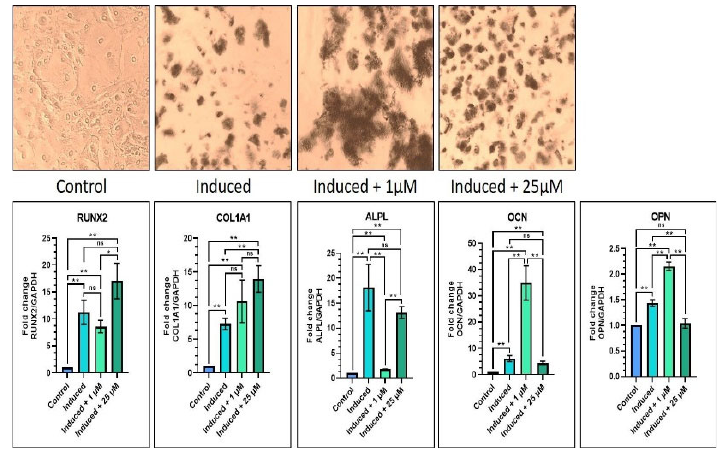
Figure 4. Comparative osteogenic differentiation (von Kossa staining) of DPSCs with low (1 µ M) and high (25 µ M) concentrations of melatonin and RT-qPCR-based gene expression analysis of osteogenesis-related genes. Scale bar: 200 µ m. ns, not significant; * p < 0.05 and ** p < 0.01. With regard to chondrogenic differentiation, there was a significant increase in SOX9, COL2A1, and ACAN gene expressions in 1 µ M melatonin (Group 3) as compared with the control (Group 1) ( p < 0.05). When equated to the induction media Group 2, the induction media with 1 μ M melatonin Group 3 caused a significant increase in SOX9 and COL2A1 geneexpression ( p < 0.05), while there was a notable reduction in ACAN gene expression ( p < 0.05). In addition, the induction media with 1 μ M melatonin had signifi ‐ cantly increased expression of COL2A1 and ACAN ( p < 0.05) (Table 7 and Figure 5). The toluidine blue staining images showed a similar trend among Groups 2, 3 and 4, with low staining intensity when compared with the abovementioned groups (Figure 5).